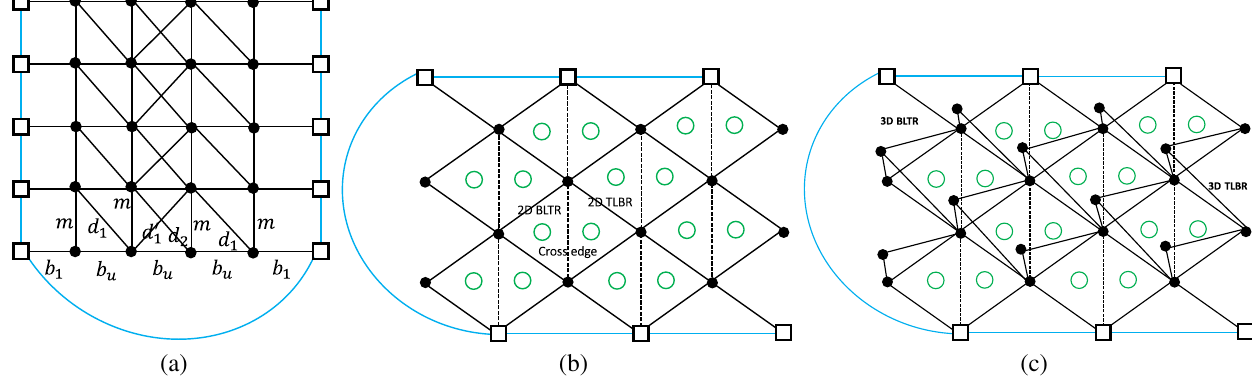
FIG. 5. (a) Example of the minimum-weight-matching graph for five rounds the X -type gauge measurements of the d ¼ 5 heavy- hexagon code. Since only the stabilizer measurements are used to correct errors, the graph is one dimensional for one measurement round. Diagonal edges connecting two consecutive one-dimensional graphs are necessary to correct space-time-correlated errors arising from CNOT gate failures. The weights and directions of the diagonal edges depend on the CNOT gate scheduling and are chosen such that a single fault in the measurement circuits corresponds to an edge in the final graph. Labels m , b 1 , b , d 1 , d 0 1 , and d 2 correspond to edges u with different weights computed based on the probabilities of occurrence for a given edge. The edge d 0 1 is a bulk feature that appears only in odd columns excluding the first and last column (for instance, columns three and five in the d ¼ 7 graph would contain edges d 0 1 ). More details are given in Appendix A. (b) Example of the minimum-weight-matching graph for one round of the Z -type stabilizer measurements of the d ¼ 5 heavy-hexagon code. The full graph for d rounds of Z -type stabilizer measurements is three dimensional. Cross edges are given by dashed lines since they are present only in the presence of nontrivial flag measurement outcomes (during the X -type gauge measurements) represented by green circles. More details are provided in Sec. III. (c) Diagonal edges connecting two- dimensional graphs are added to ensure that a single fault in the measurement circuits corresponds to an edge in the final from the flag measurement outcomes to correct errors up to